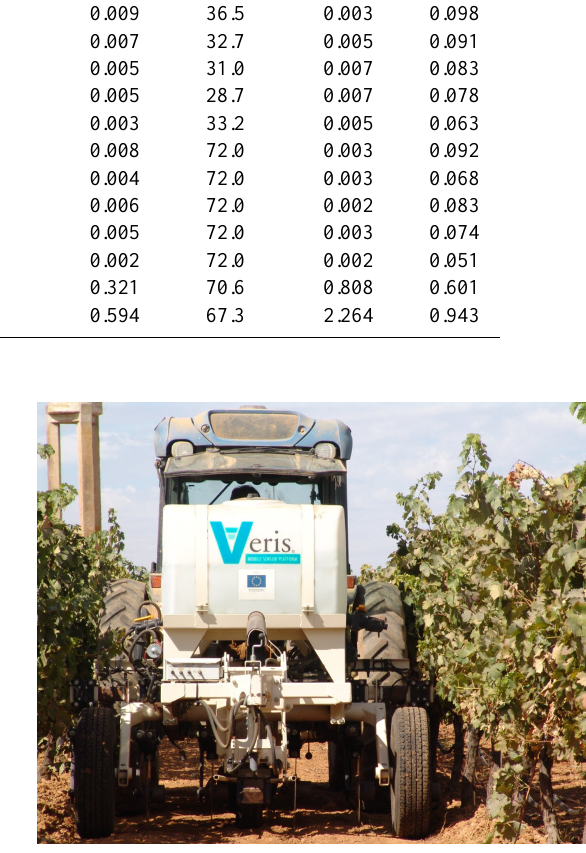
Figure 3. Mobile sensor platform Veris 3150 for ECa